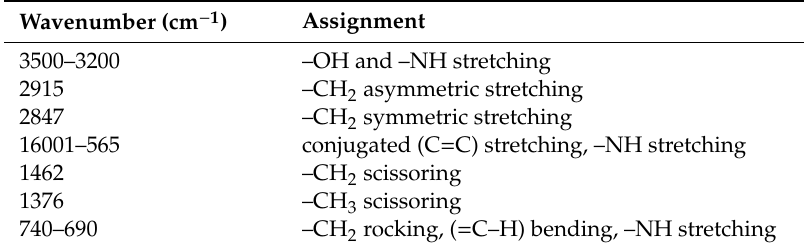
Table 2. FTIR frequencies and vibrational assignments for